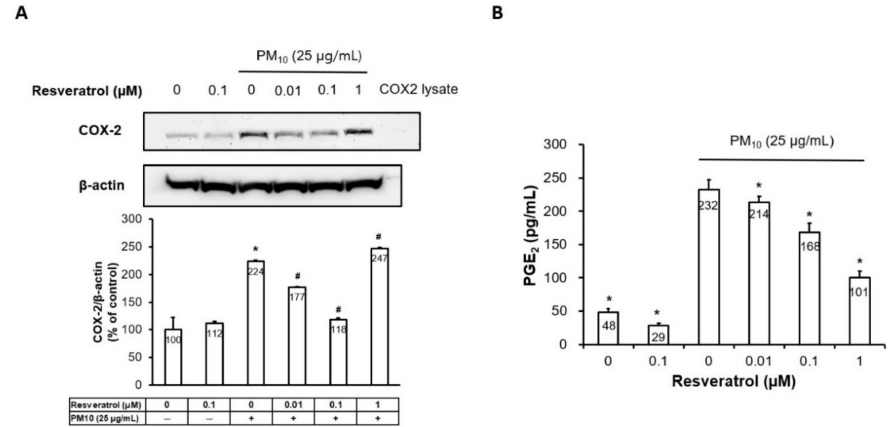
Figure 3. E ff ect of resveratrol on PM-induced COX-2 expression and PGE2 generation in human keratinocytes. ( A ) The protein expression of COX-2 determined by Western blot and densitometry. Equal amounts of protein loading were verified using an anti-actin antibody, ( B ) PGE2 generation measured by ELISA, Data are presented as the mean ± standard deviation of three independent experiments ( n = 3). * p < 0.05 and # p < 0.01 compared with untreated cells and PM-treated cells, respectively. PM, particulate matter, COX-2, cyclooxygenase-2, PGE2, prostaglandin E2, ELISA, enzyme-linked immunosorbent assay.